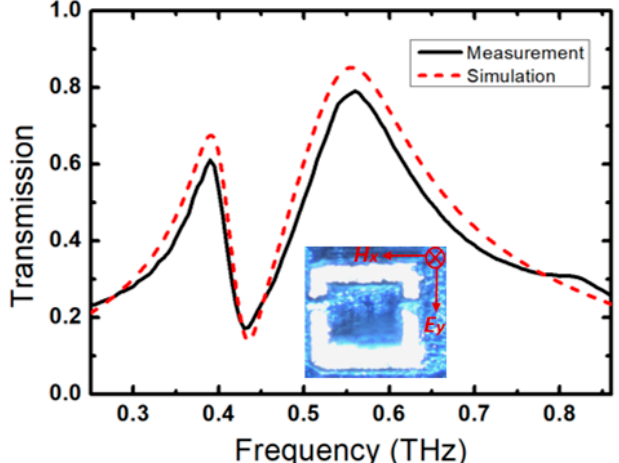
Figure 3. Measured and simulated transmission spectra of FCA-SRR with E-field orientation along y-direction as shown in the inset of the figure when δ = 10.9%.